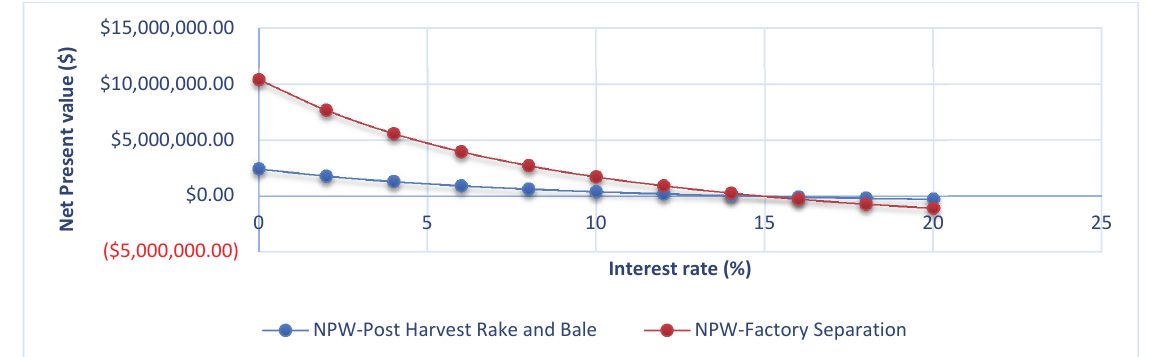
Fig. 11. Net Present Worth - cane factory separation and Rake and Bale